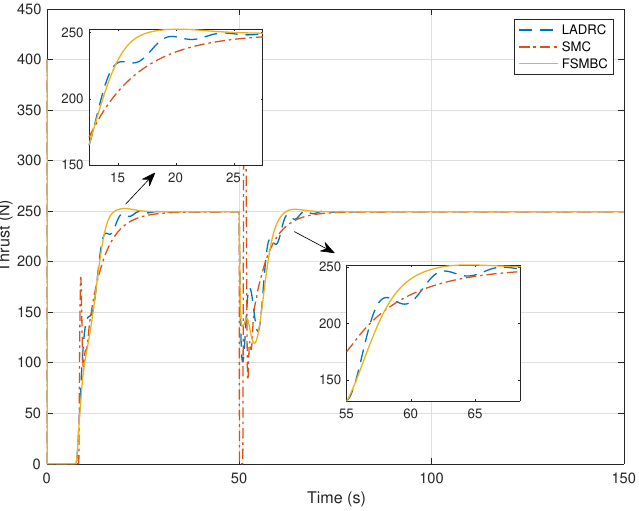
Figure 11. Thrust inputs for LADRC, SMC, and FSMBC for variable altitude control.